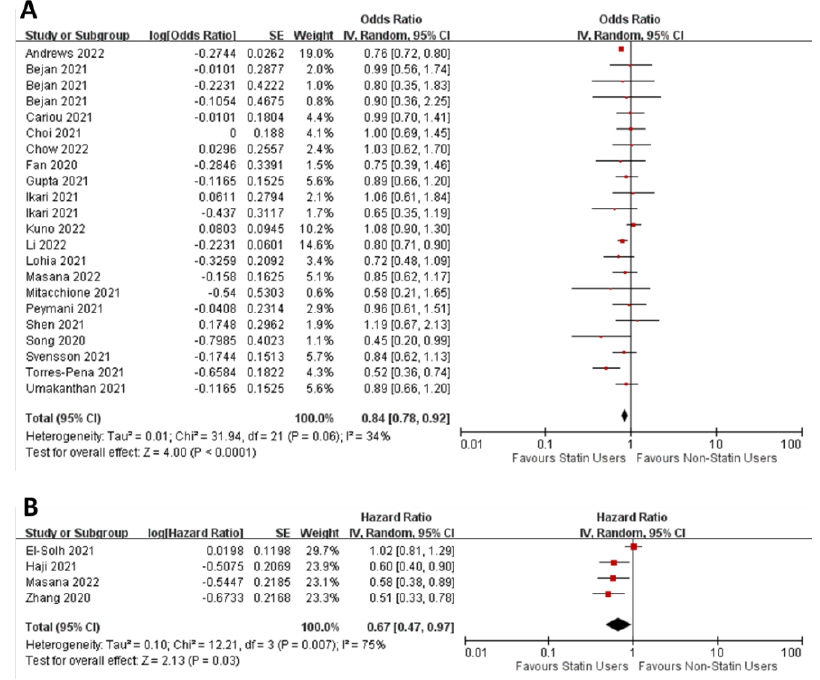
Figure 4. Forest plots of adjusted odds ratio ( A ) and hazard ratio ( B ) for mechanical ventilation in statin users versus non-users among COVID-19 patients.